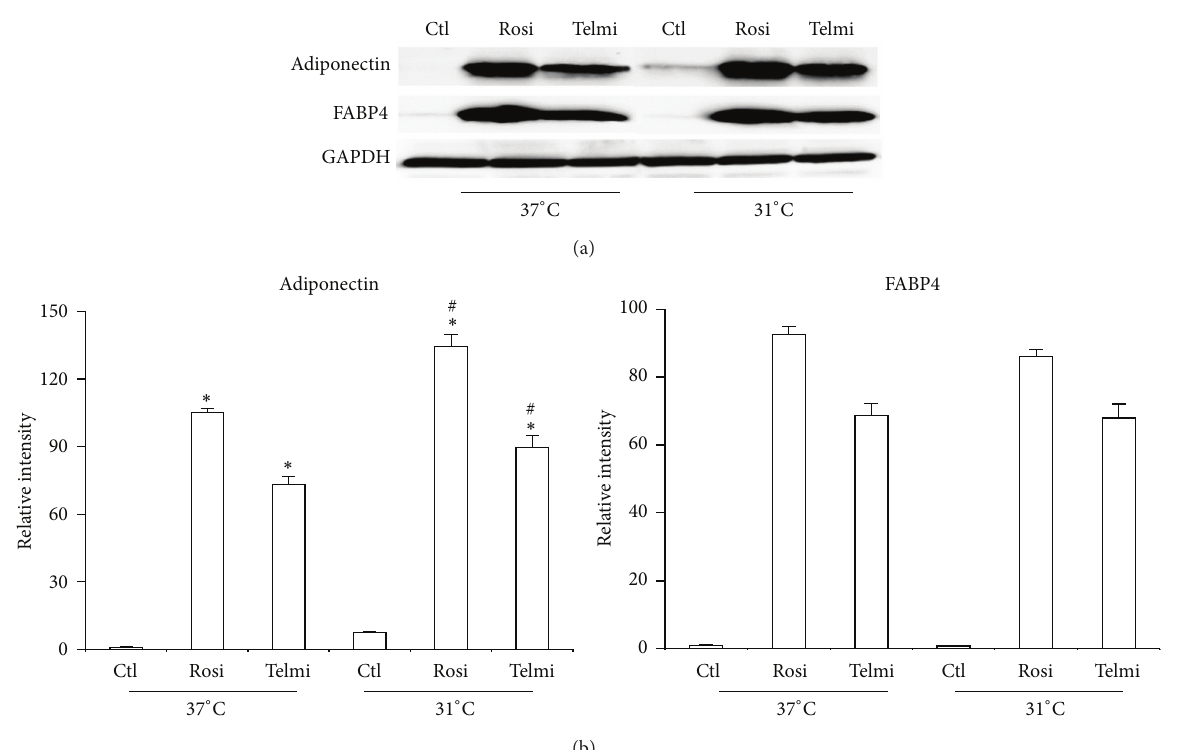
Figure 3: Effect of cold in the levels of adipocytokines. (a) The differentiated adipocytes were obtained and treated as described in Figure 1; total protein was isolated for detecting expression of adiponectin and FABP4 by western blot. (b) Relative intensity levels were determined by densitometry of bands. Analyses were performed using ANOVA test. Data are expressed as mean ± SD and differences were considered significant with 𝑃 < 0.05 . ∗ Differences between total and partial agonist in relation to control. # indicates meaningful differences observed after 4 hours of treatment with agonists after exposure to cold in comparison with adipocytes treated in equal conditions at 37 ∘ C. Data were normalized with